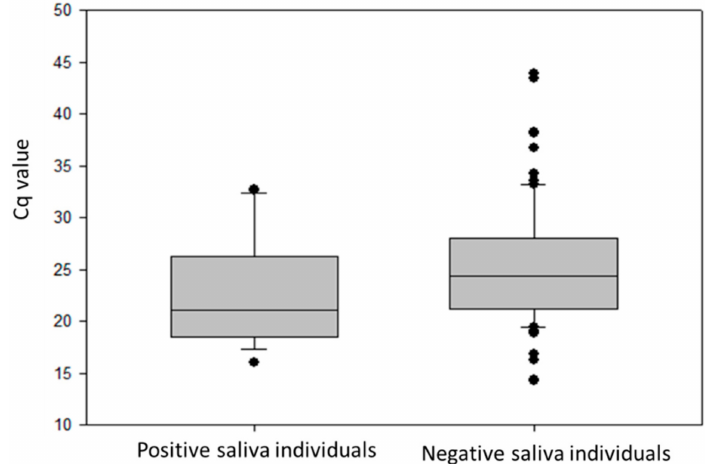
Figure 3. Viral load shed by saliva-positive and saliva-negative subjects under study, represented as box plots (median, quartiles (box), 95% range (whiskers), and outliers (circles)).